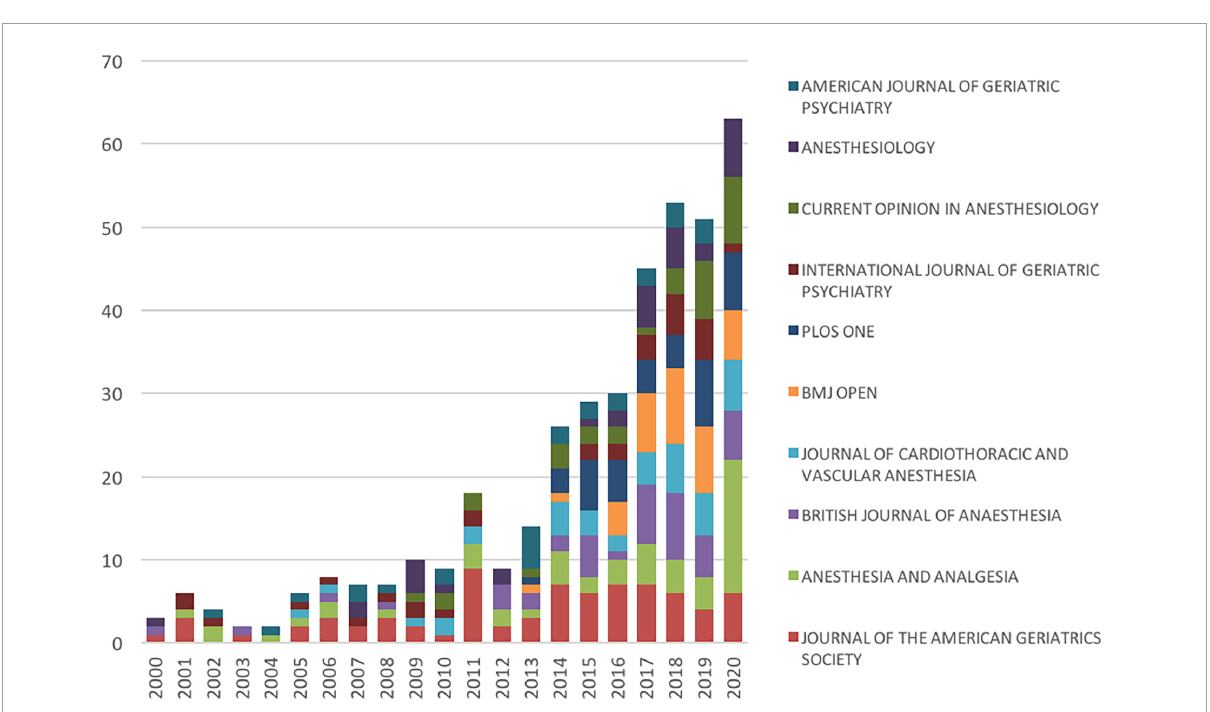
FIGURE4 The number of articles on postoperative delirium (POD) published in the top 10 journals each